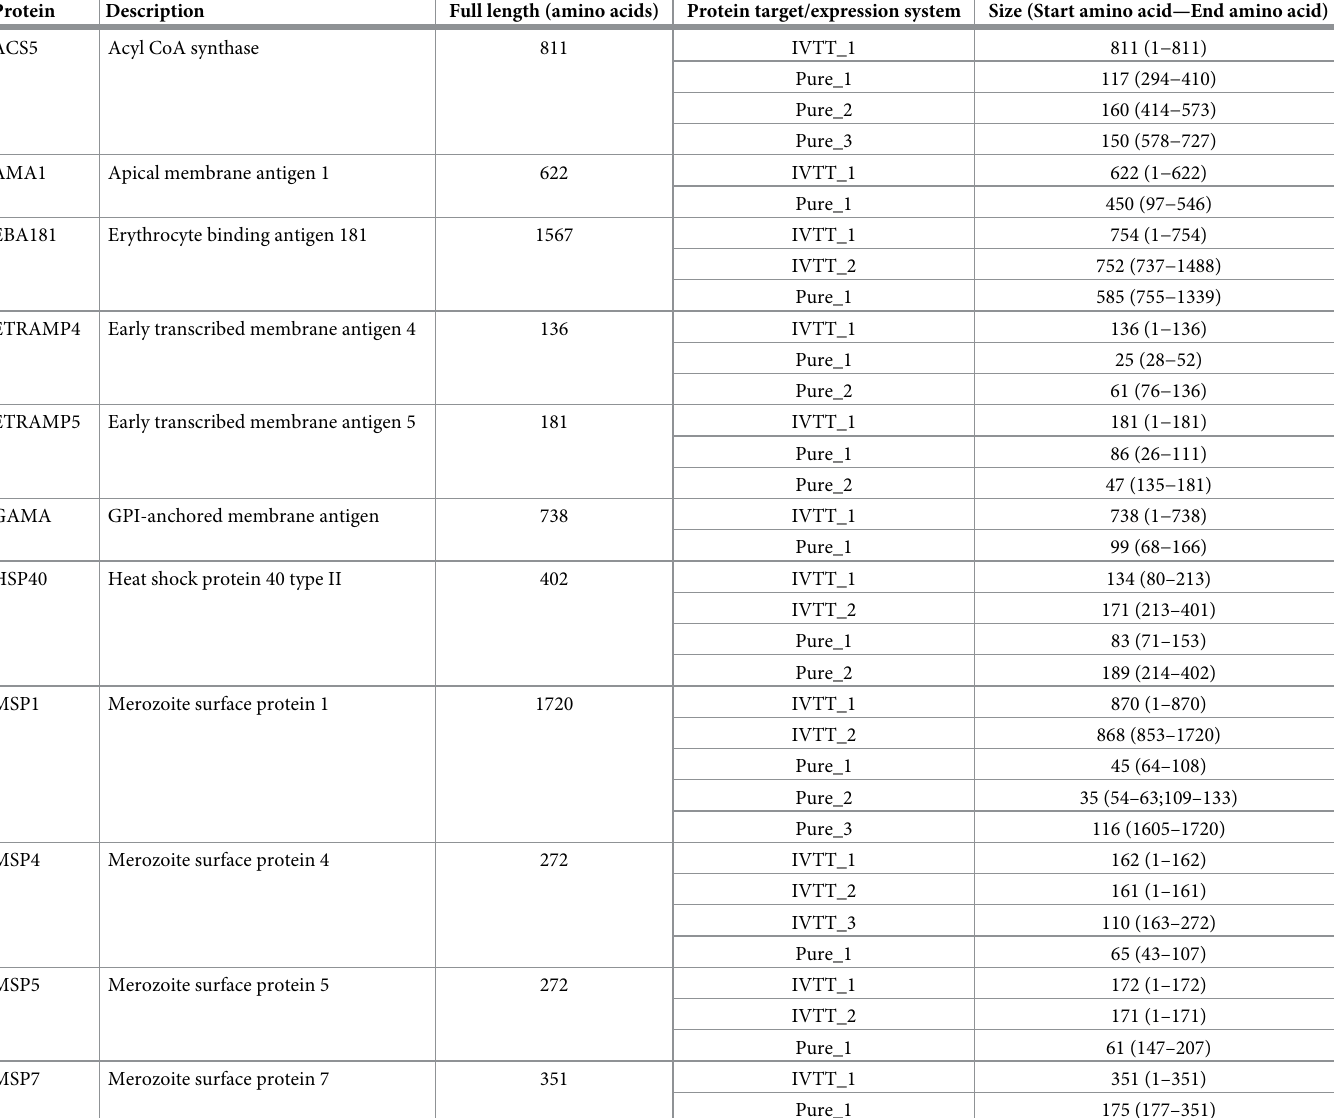
Table 1. Description of P . falciparum antigens and their corresponding IVTT and purified protein